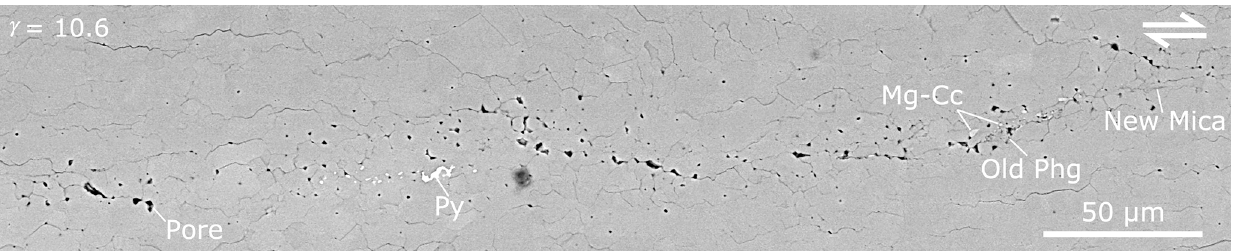
Figure 2. A more detailed view of the pore sheet labelled in Fig. 1e. Please find supporting spectra from energy dispersive spectroscopy (EDS) in the Appendix for the small precipitates (Py – pyrite, Phg – phengite, Mg-Cc – magnesium